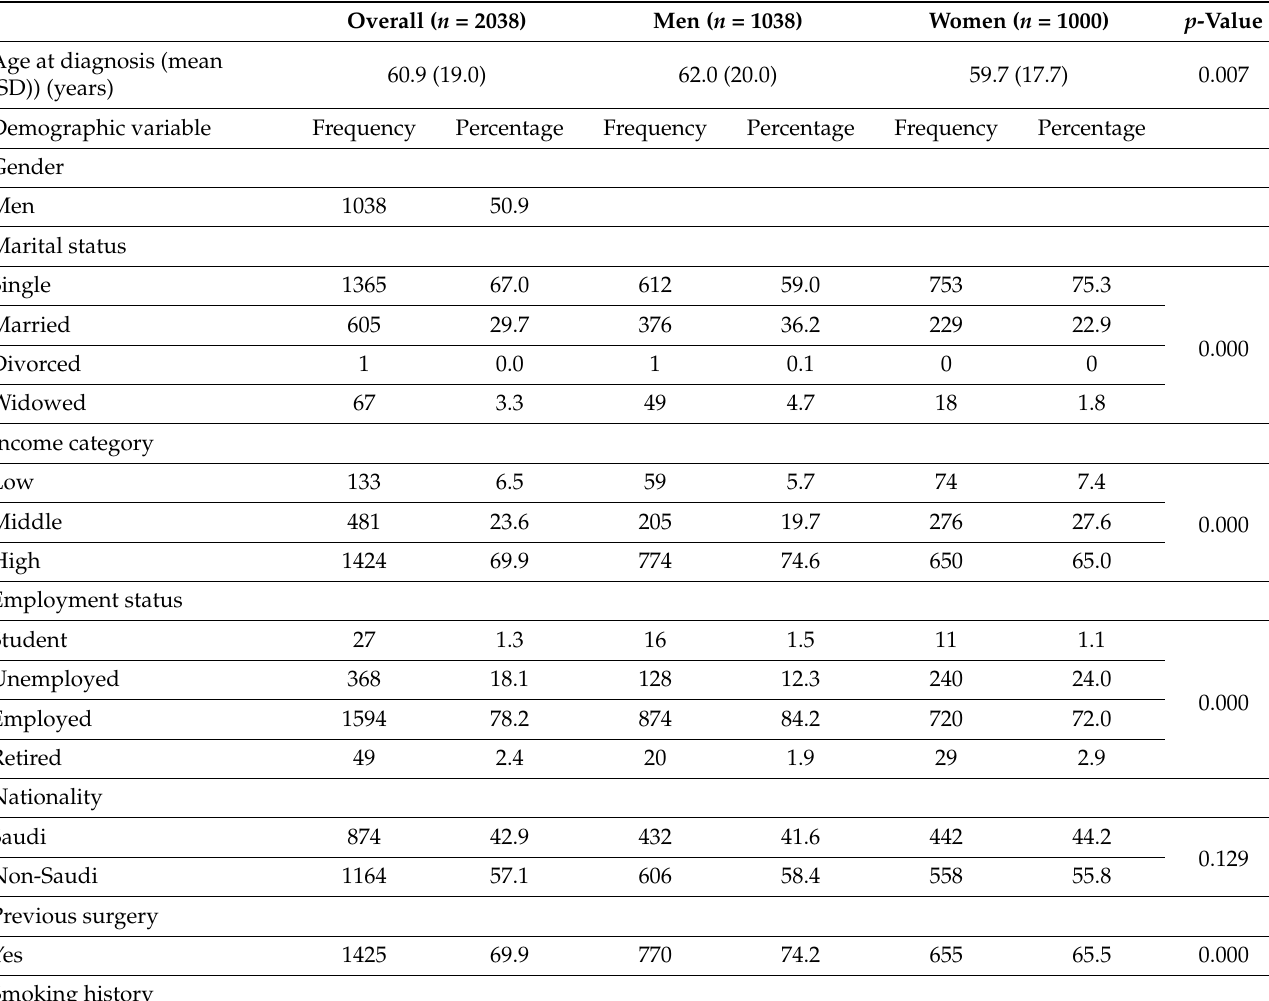
Table 1. Patients’ baseline